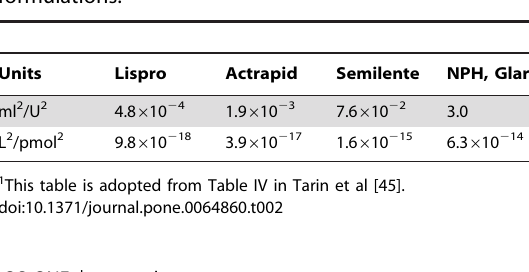
Table 2. Values of parameter q for different insulin formulations. 1